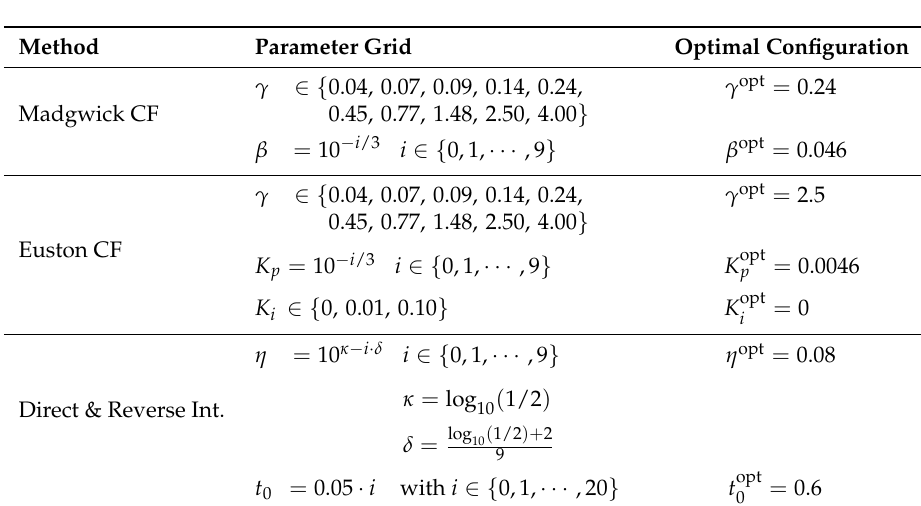
Figure 4. Pooling of individual error distributions yields the error distributions (cid:101) ( α i , θ ) for a given axis i = z , variable and parameter configuration θ . Table 1. Parameter grids for all methods optimized by grid-search on the current dataset and the resulting optimal parameter